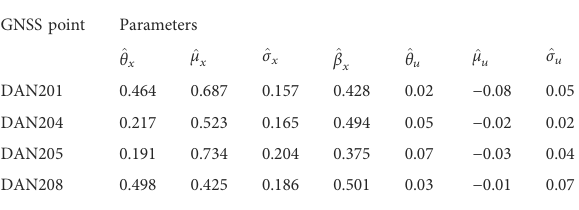
TABLE 2 Parameters obtained via maximum likelihood estimation. GNSS point